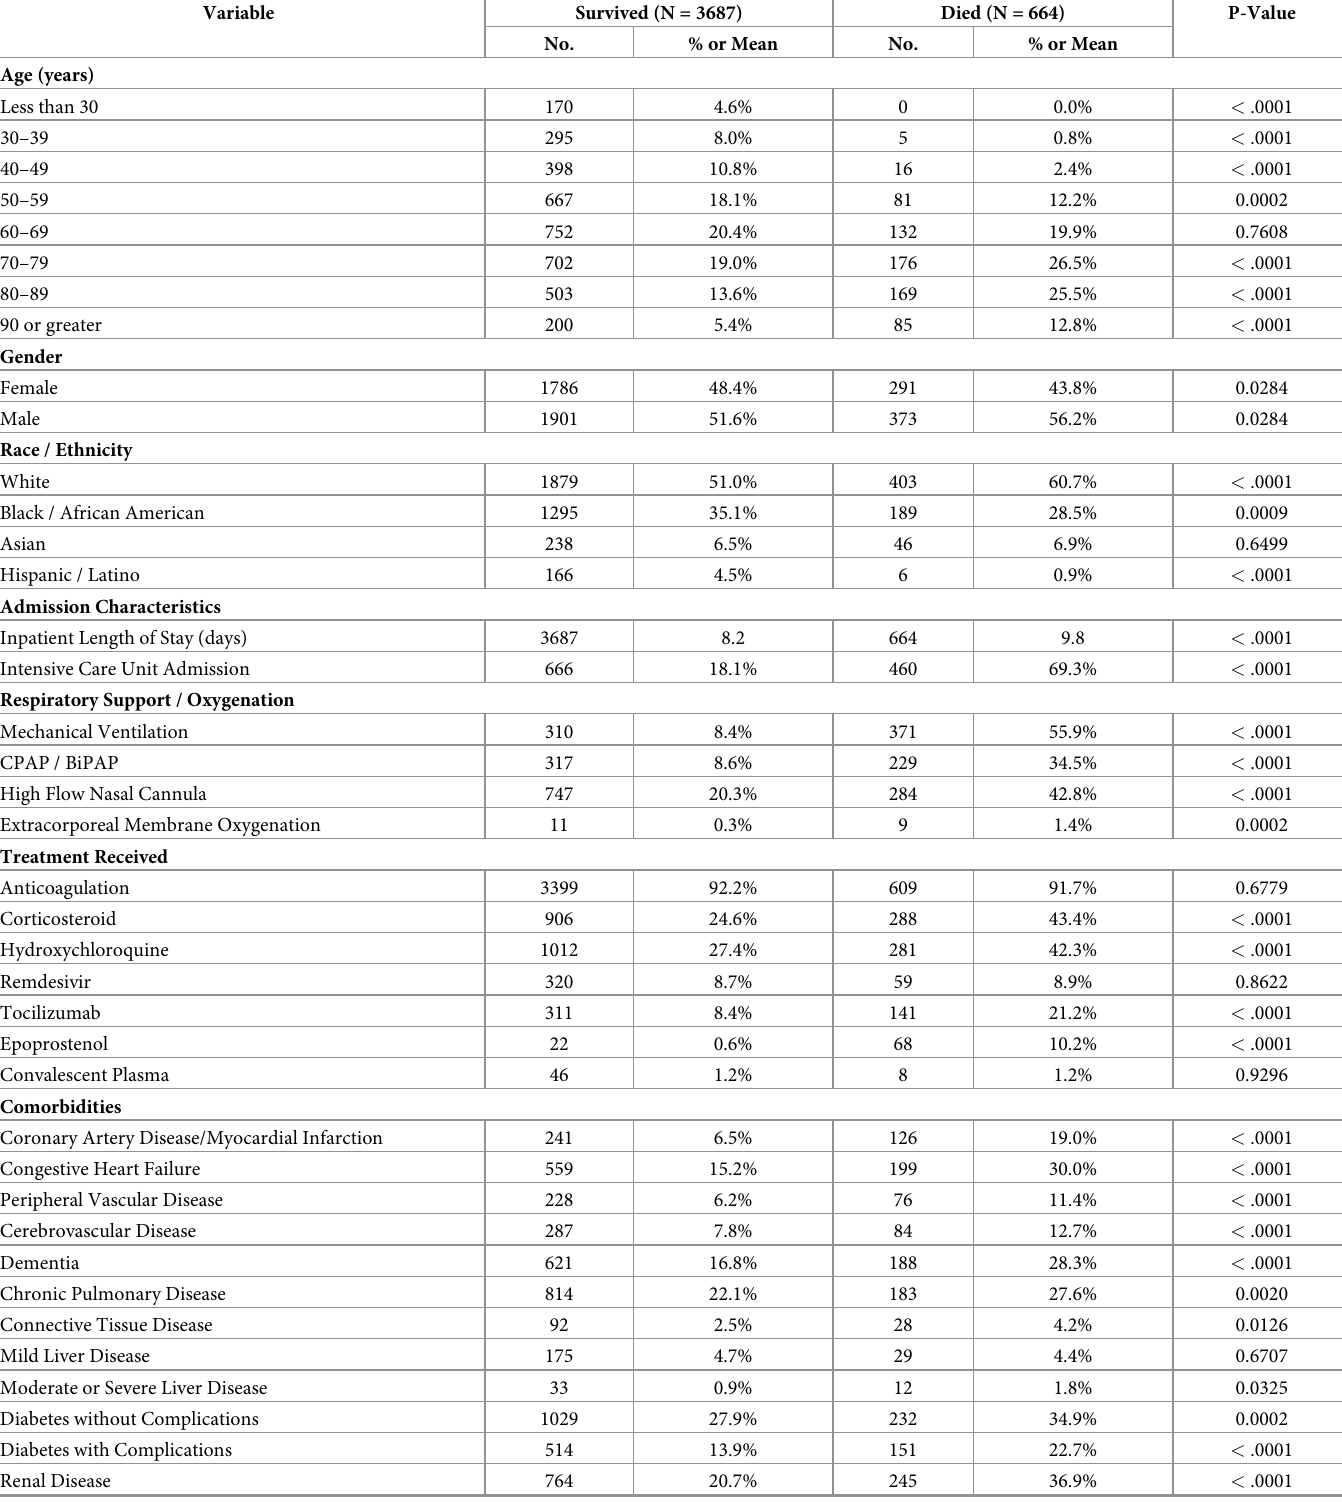
Table 1. Demographic and clinical characteristics of COVID-positive patients by mortality